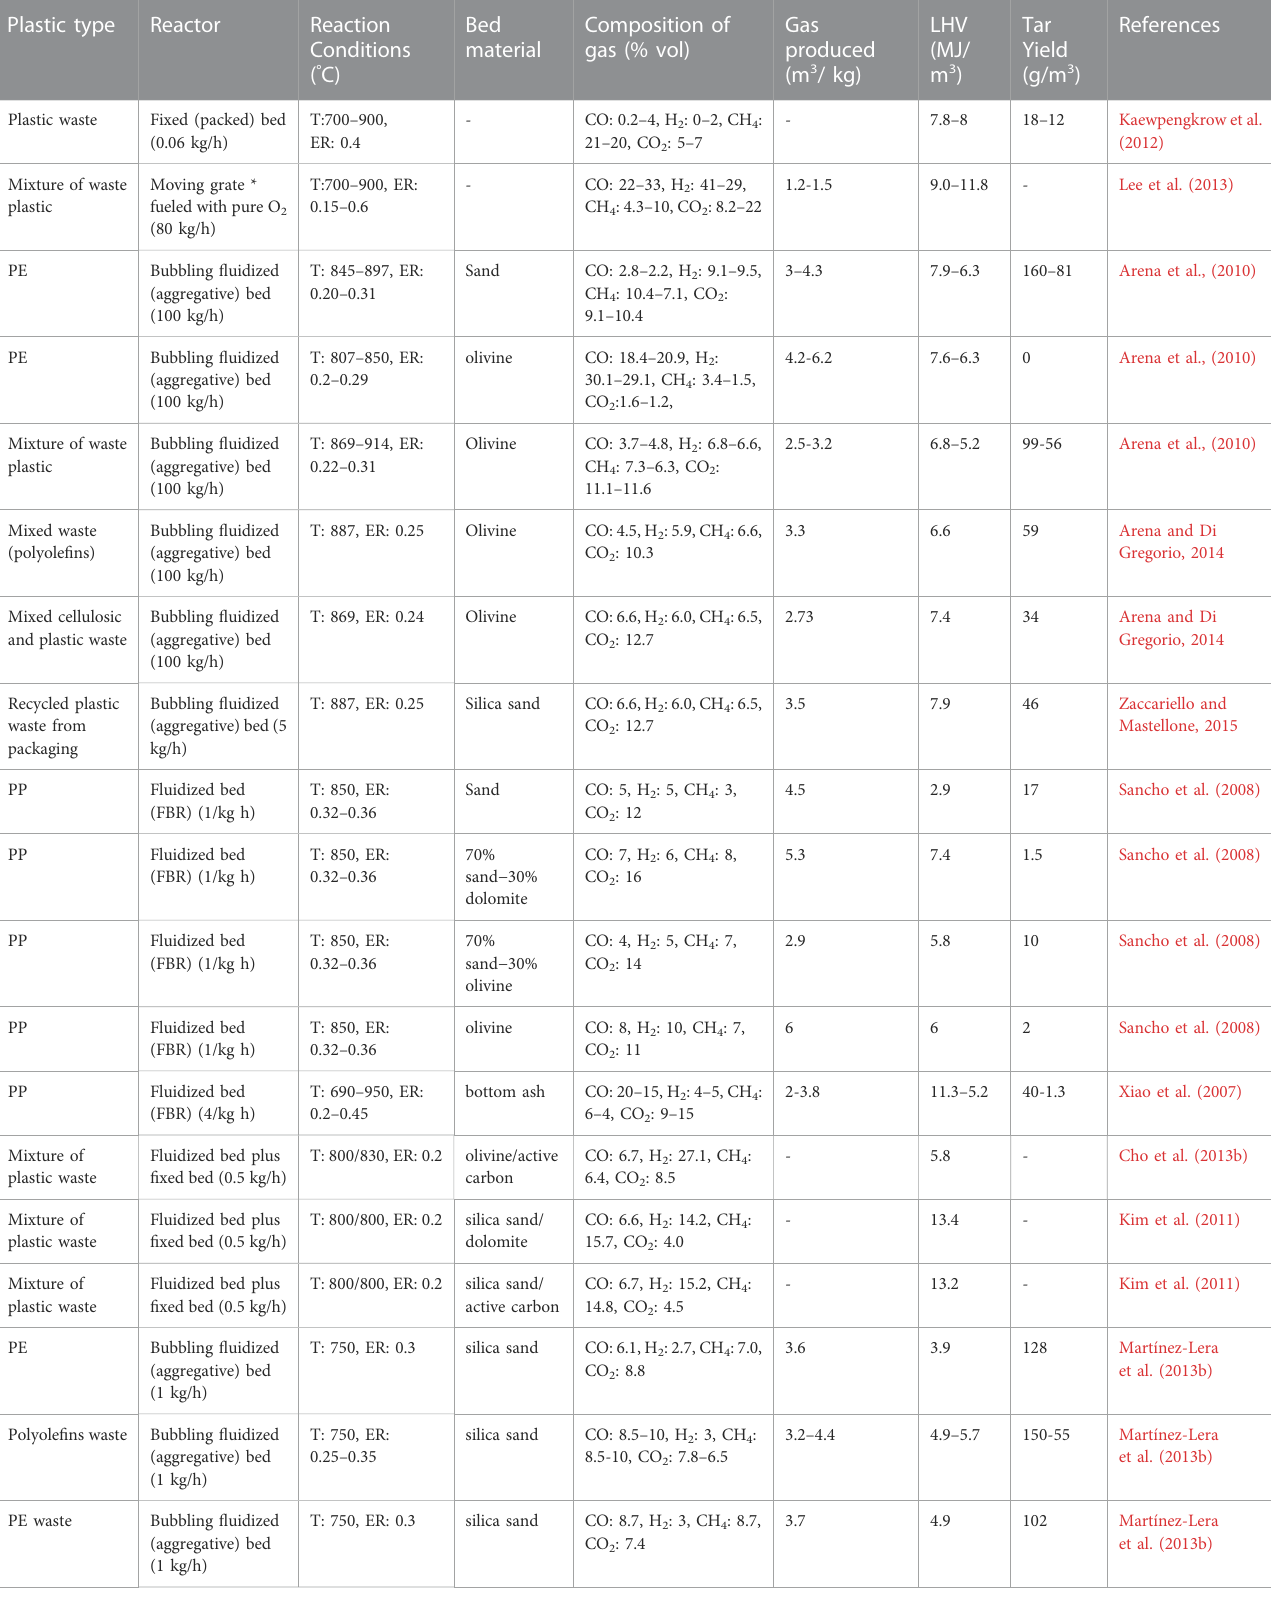
TABLE 2 Gas compositions achieved by various researchers in air gasi fi cation of plastics waste. Plastic